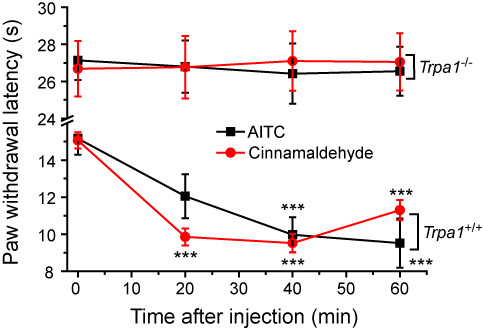
TRPA1 agonists AITC and cinnamaldehyde evoke cold hypersensitivity. Intraplantar injection of either AITC (100 μg) or cinnamaldehyde (50 μg) evoked marked cold hypersensitivity in the ipsilateral paw of lightly restrained wild-type mice but had no effect when administered to Trpa1-/- mice. Data show mean ± SEM for 6 mice/group. *** p < 0.001 vs pre-dose latencies.